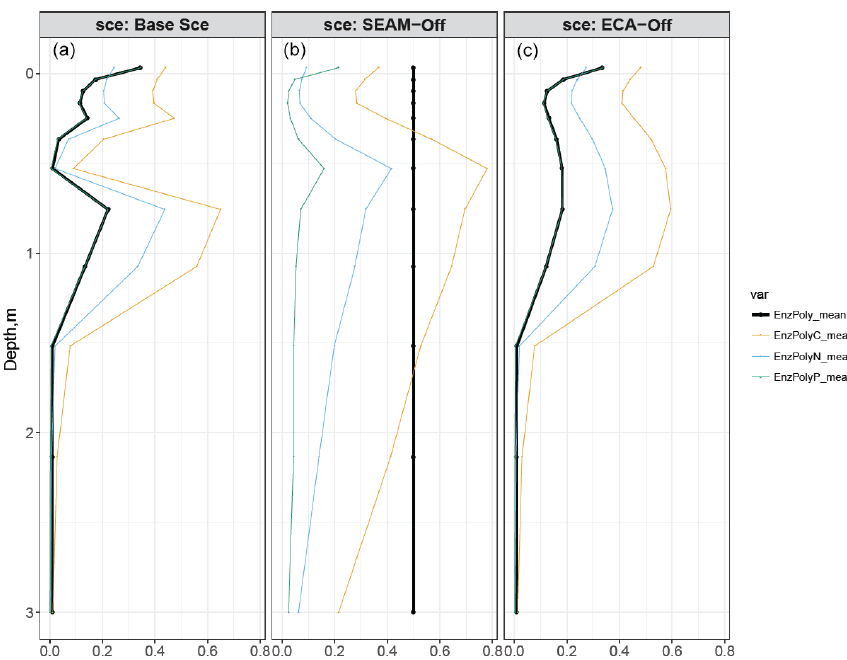
Figure 9. Simulated enzyme allocation to polymeric litter compared with potential enzyme allocations to polymeric litter given that the element C, N or P is the most limiting. Black lines: fraction of enzyme allocated to polymeric litter; orange, blue or green lines: potential enzyme allocation to polymeric litter to maximise C, N or P, respectively. (a) Base Scenario; (b) SEAM-off scenario; (c) ECA-off scenario. All data points are derived from data from the last 10 years of model